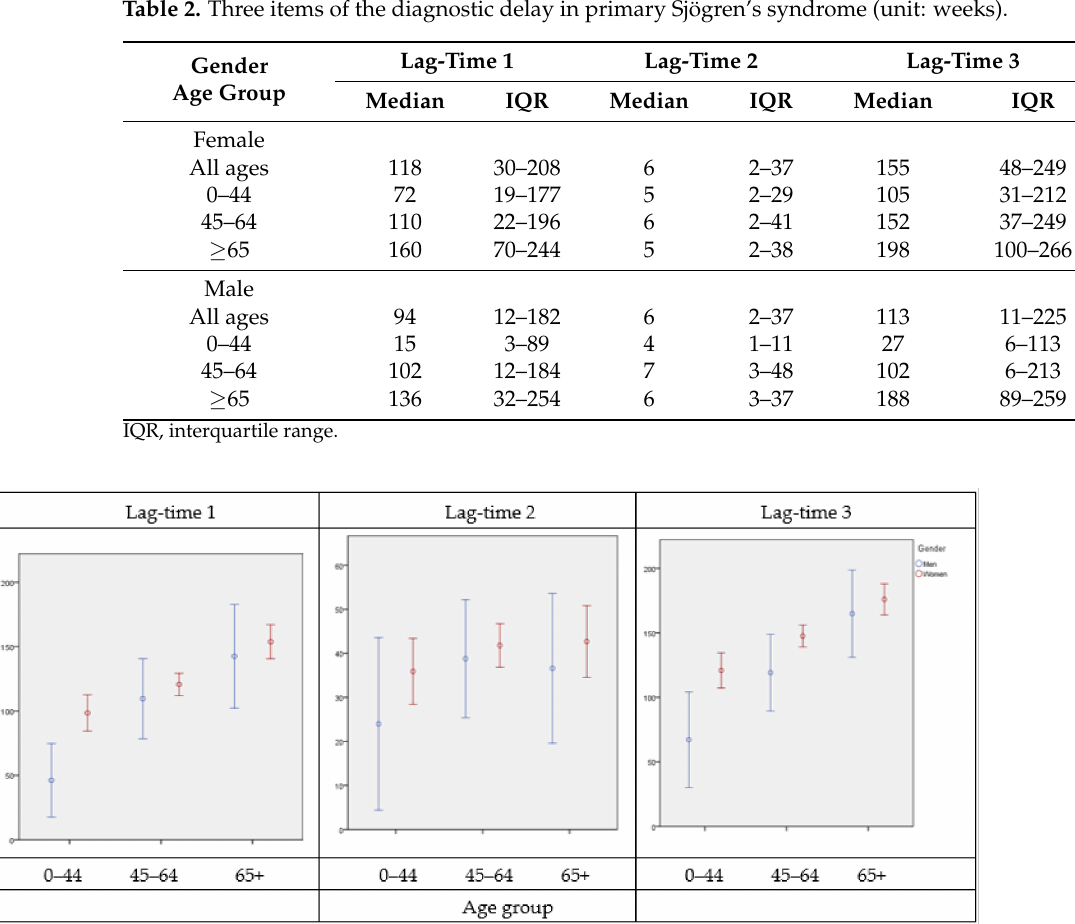
Figure 3. Lag time of sicca symptoms, diagnosis, and catastrophic illness certificate (CIC) issuance for primary Sjögren’s syndrome (pSS) by sex and age